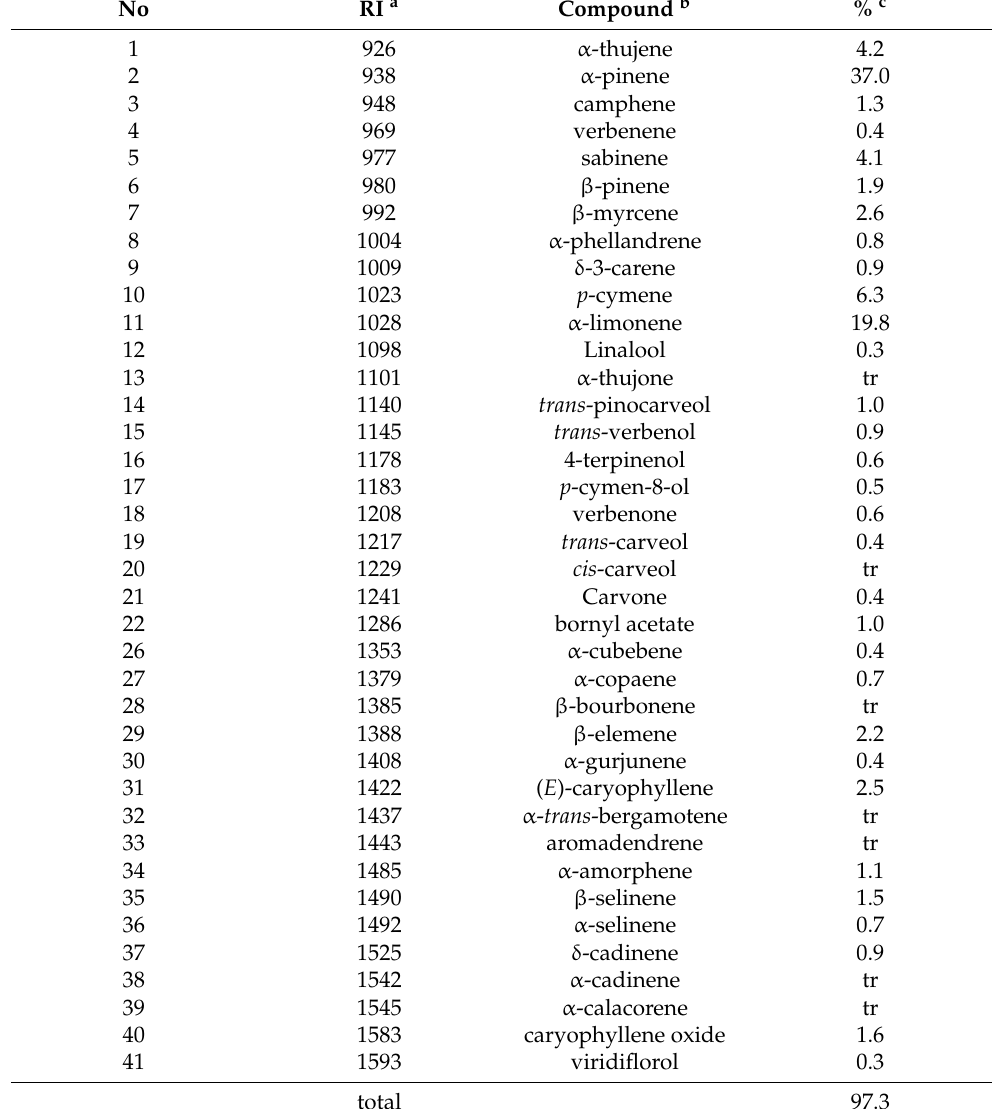
Table 1. Chemical composition of FEO.